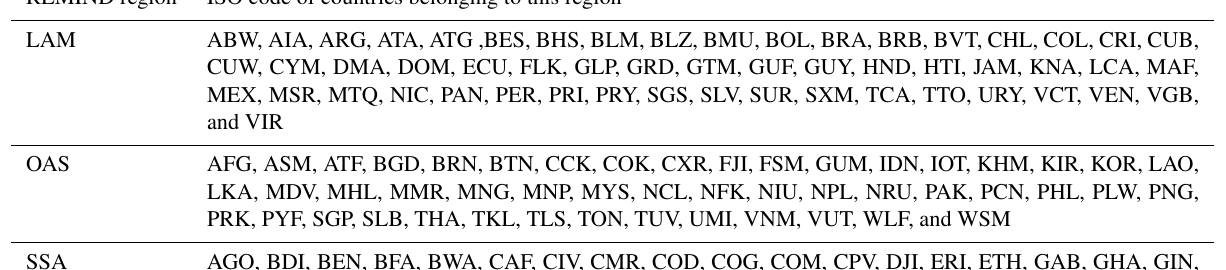
Table B1. Regional mapping of REMIND regions and countries. REMIND